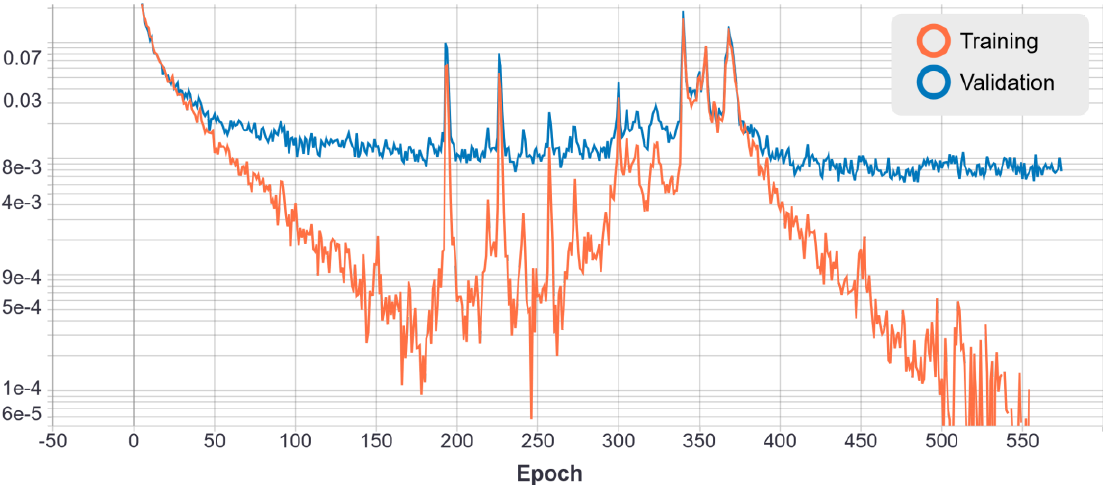
Figure 9. Neural network loss value during training. Estimated loss is calculated for a randomly sampled batch of 2048 triplets.